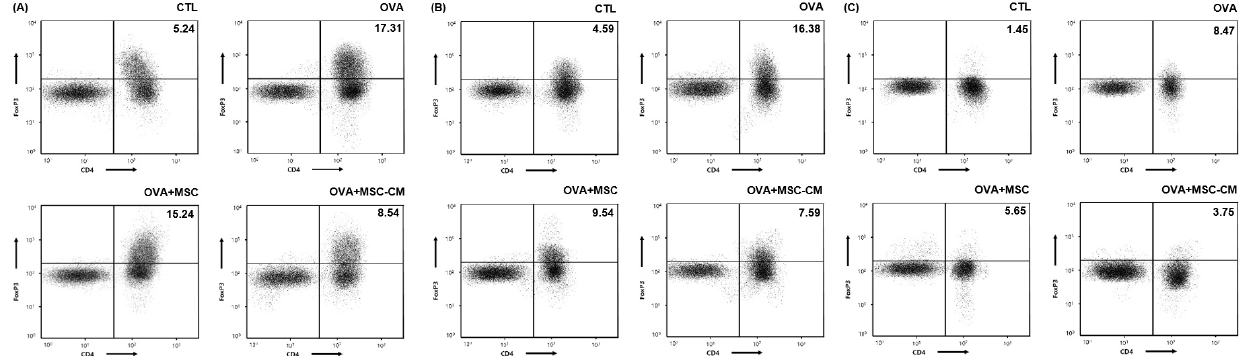
Figure 6. OVA challenge increased CD4+ Foxp3+ T cells and MSC or MSC CM reversed the change in the ear skin, mLN, and SI tissue. CD4+ Foxp3+ T cells in the ( A ) ear skin, ( B ) mLN, and ( C ) SI tissue measured by flow cytometry are shown. Mean percentage (CD4+ Foxp3+ T cell counts/total cell counts) is shown in the right upper side. CD, cluster of differentiation; Fox, forkhead box; mLN, mesenteric lymph node; MSC, mesenchymal stem cell; MSC CM, mesenchymal stem cell culture medium; OVA, Ovalbumin; SI, small